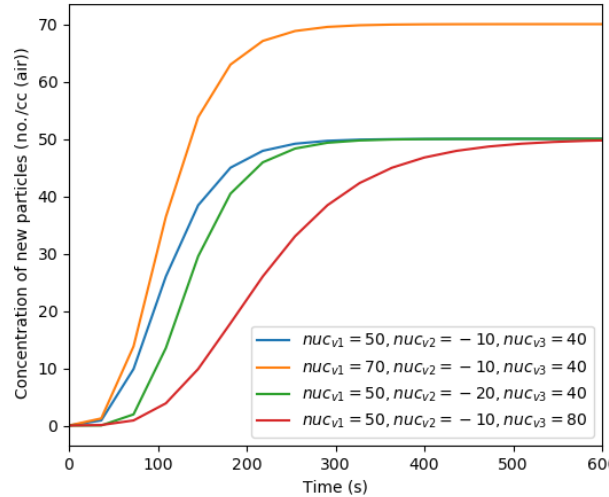
Figure 10. Effect of varying the nucleation parameters on simulated particle number concentration when considering only